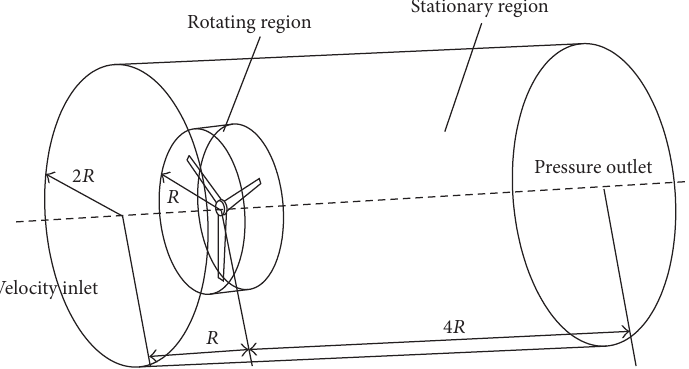
Figure 10: Simulation domains and boundary